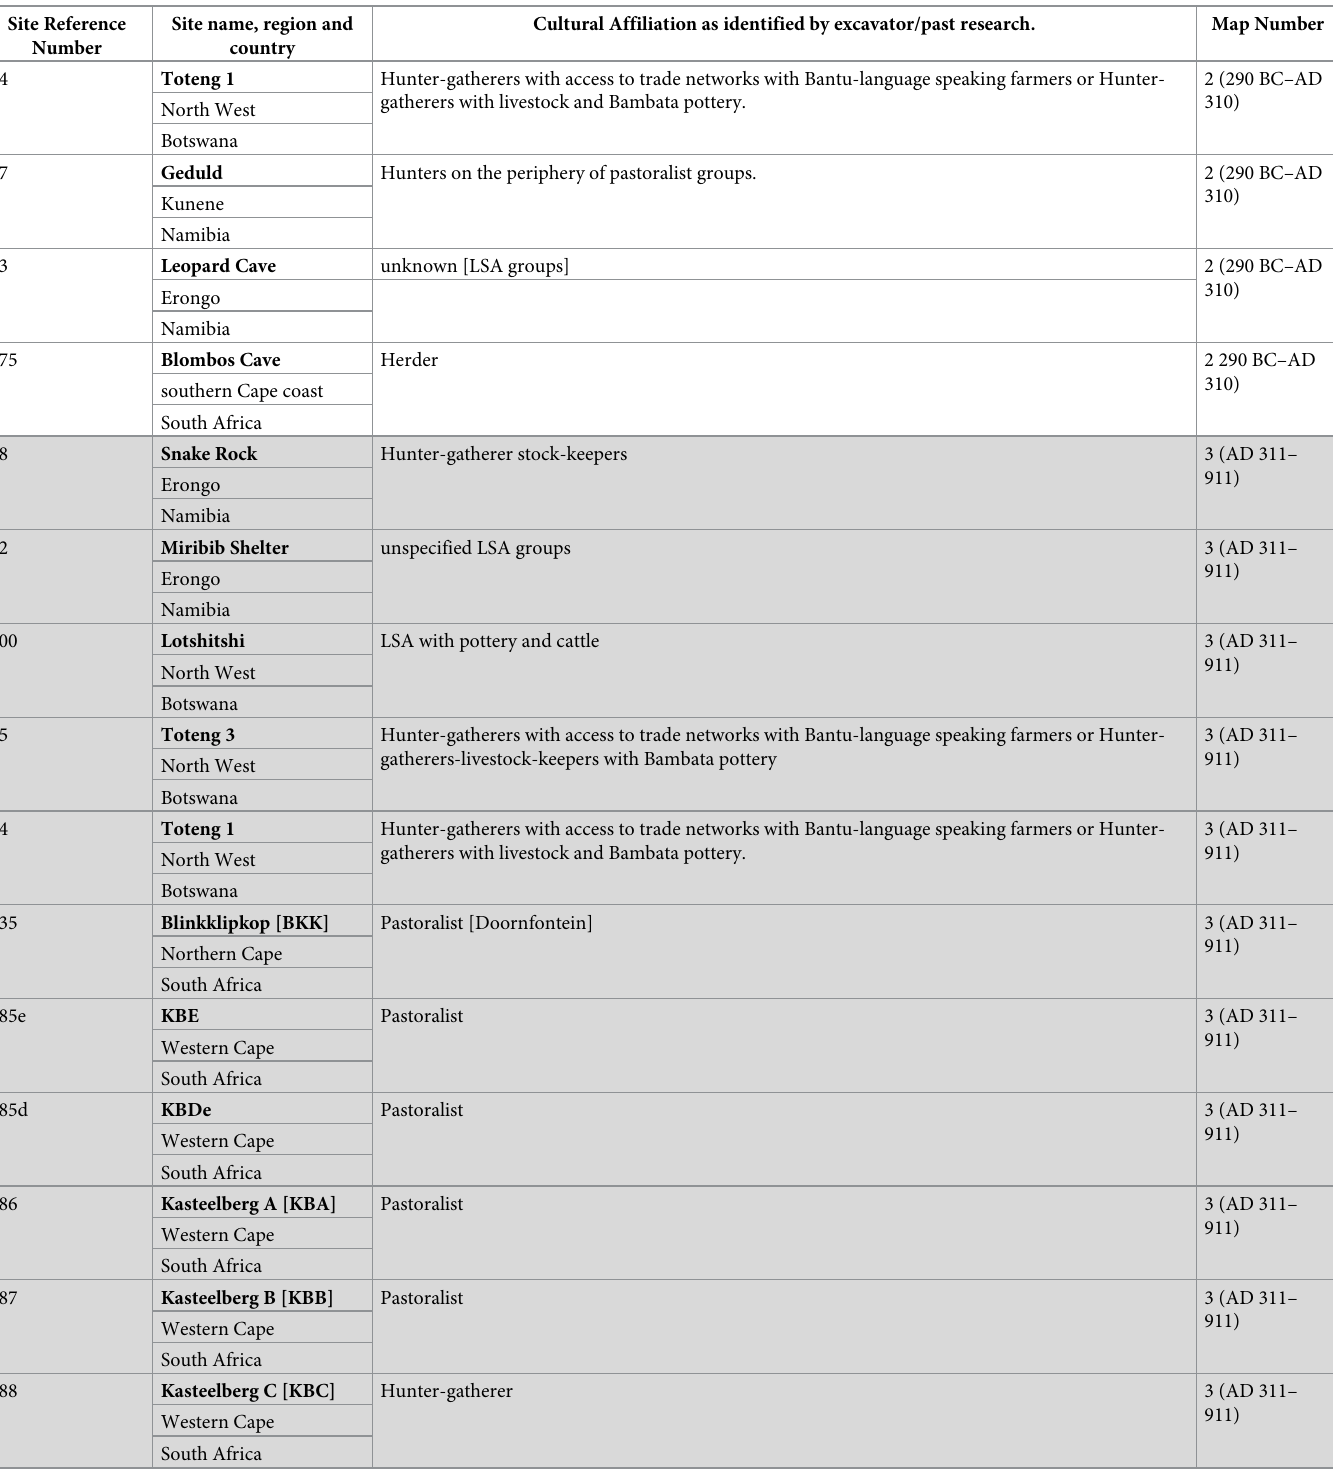
Table 2. Sites that potentially represent pastoralist presence in southern Africa in the given time